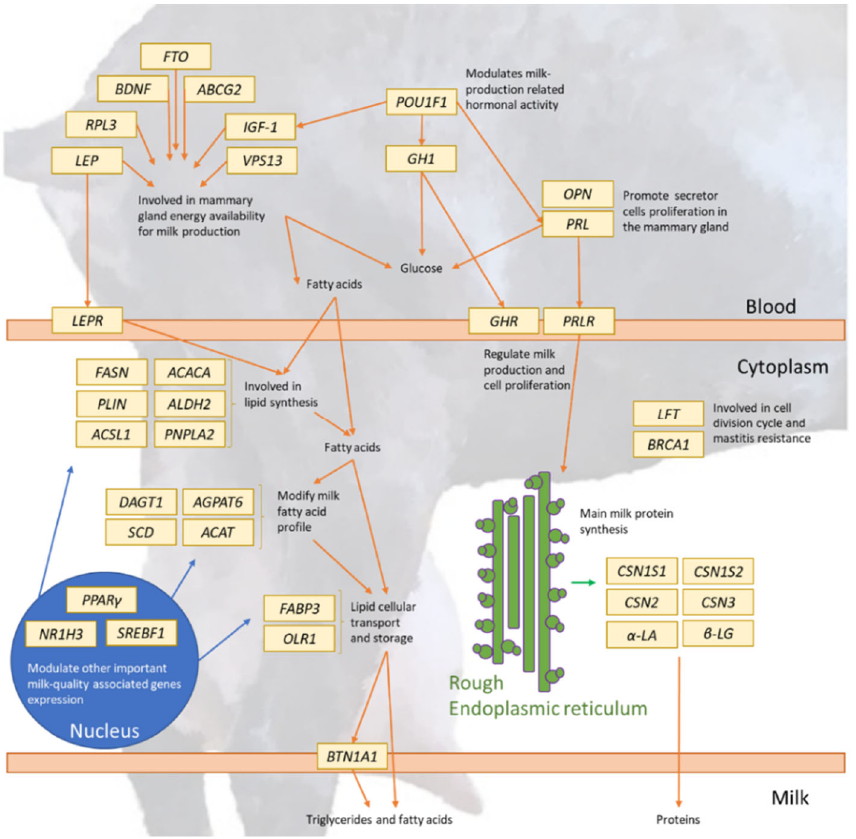
Figure 4. Dairy goat candidate genes interrelations’ scheme.